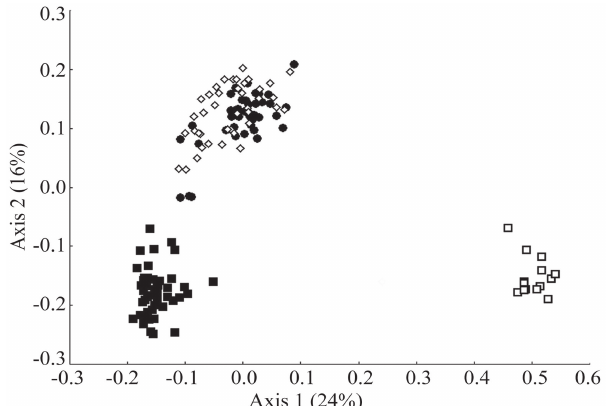
Fig. 2. Scatter plot, ordered through the main coordinates (PCoA) based on the Jaccard dissimilarity index. Specimens of Arapaima gigas belonging to (black circle) Araguaiana, (black square) Novo Santo Antônio, (white lozenge) São Félix do Araguaia and (white square) Itupiranga. A similar result was obtained with a Bayesian inference, which indicated a value of k equal to three populations. These populations are divided according to the sampling sites. The specimens of Novo Santo Antônio and Itupiranga are two separate populations and the specimens of São Félix do Araguaia and Araguaiana form a single population (Fig. 3).